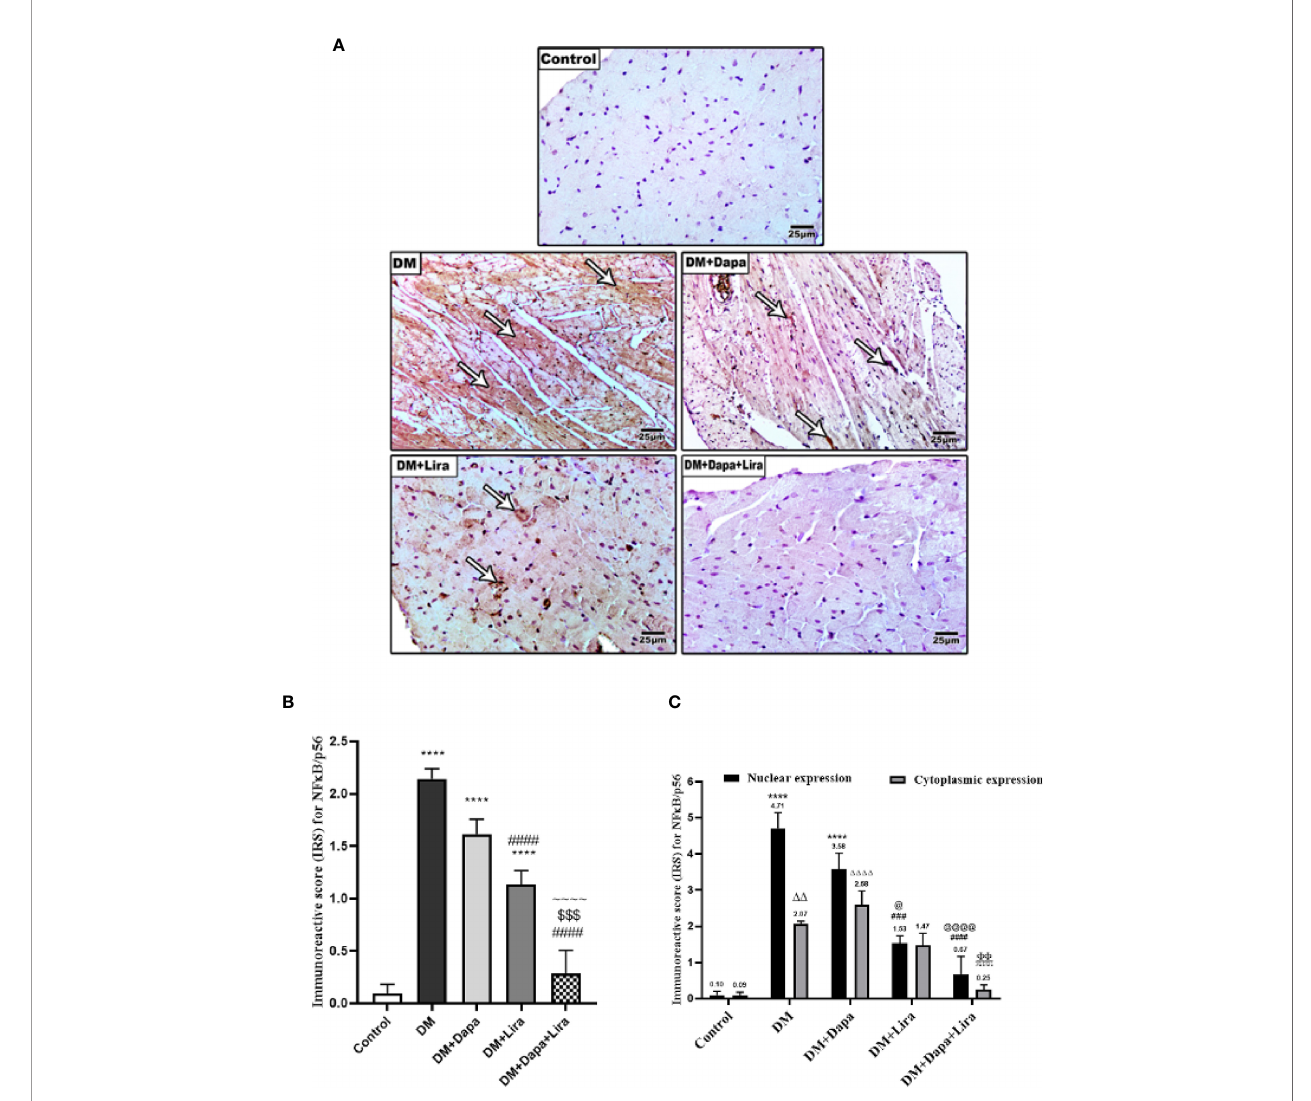
FIGURE 6 | (A) Representative photomicrographs of NF- k B/p56 immuno-stained cardiac sections from different experimental groups, ×200 bar 50. (B) A graph showing immunoreactive score for NF- k B/p56 cellular expression. Data are represented as mean ± SE, n = 6. **** signi fi cance in comparison with control group at p < 0.0001, #### signi fi cance in comparison with diabetic group at p < 0.0001, ~~~~ signi fi cance in comparison with DM+Dapa at p < 0.0001, $$$ signi fi cance in comparison with DM+Lira group at p < 0.001. (C) A graph showing immunoreactive score for NF- k B/p56 differentially in the nucleus and cytoplasm. Data are expressed as mean ± SEM ( n = 6). **** p < 0.0001 versus control, #### p < 0.0001, ### p < 0.001 versus diabetic group and p < 0.0001, @ p < 0.05 versus DM+Dapa for nuclear expression, DD p < 0.01, DDDD p < 0.0001 versus control, FF p < 0.01 versus diabetic group, ppp p < 0.001 versus DM+Dapa for cytoplasmic